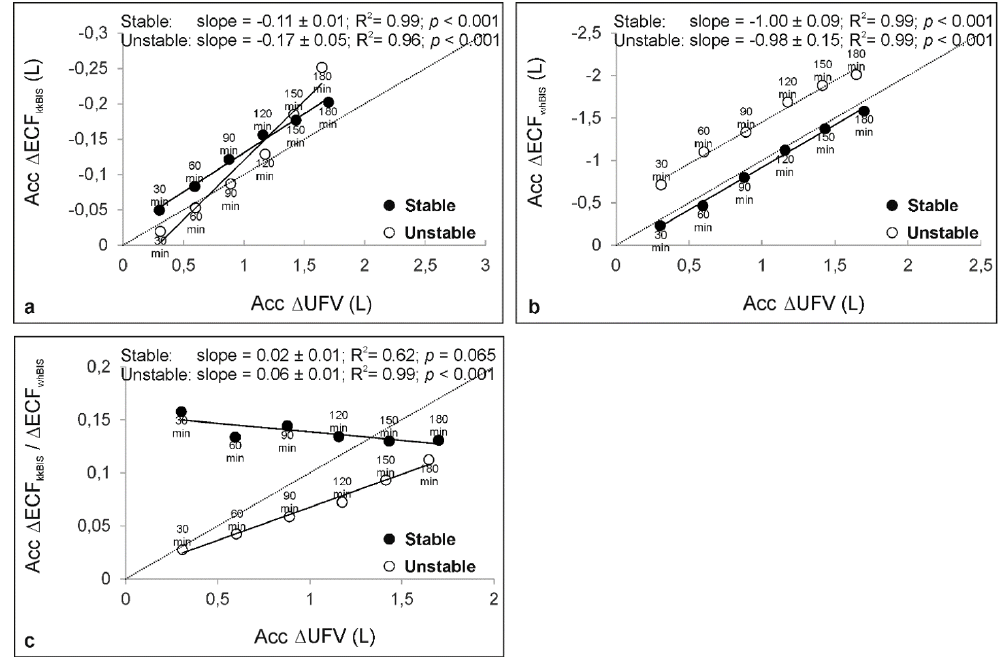
Fig.5: Data (mean ± SD) showing the accumulative changes in extracellular fluid (ECF) associated with accumulative ultrafiltration volume (UFV) as recorded by the dialysis machine during treatment at the time points 30, 60, 90, 120,150 and 180 min from the start of dialysis. SD lines were omitted from the graph to maintain visual